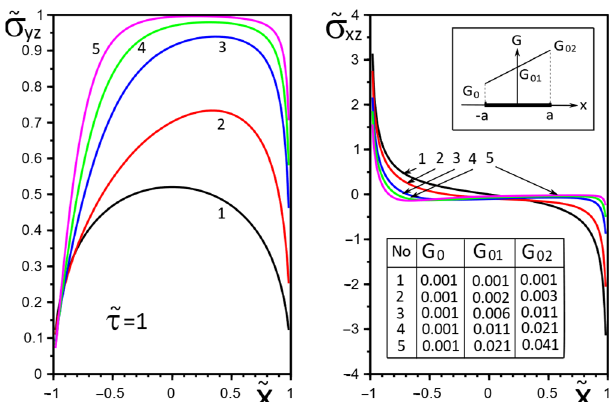
Figure 4. Stress distribution along with the upper interface (inclusion–matrix half ‐ space 2 S ) with a linear distribution of material stiffness.